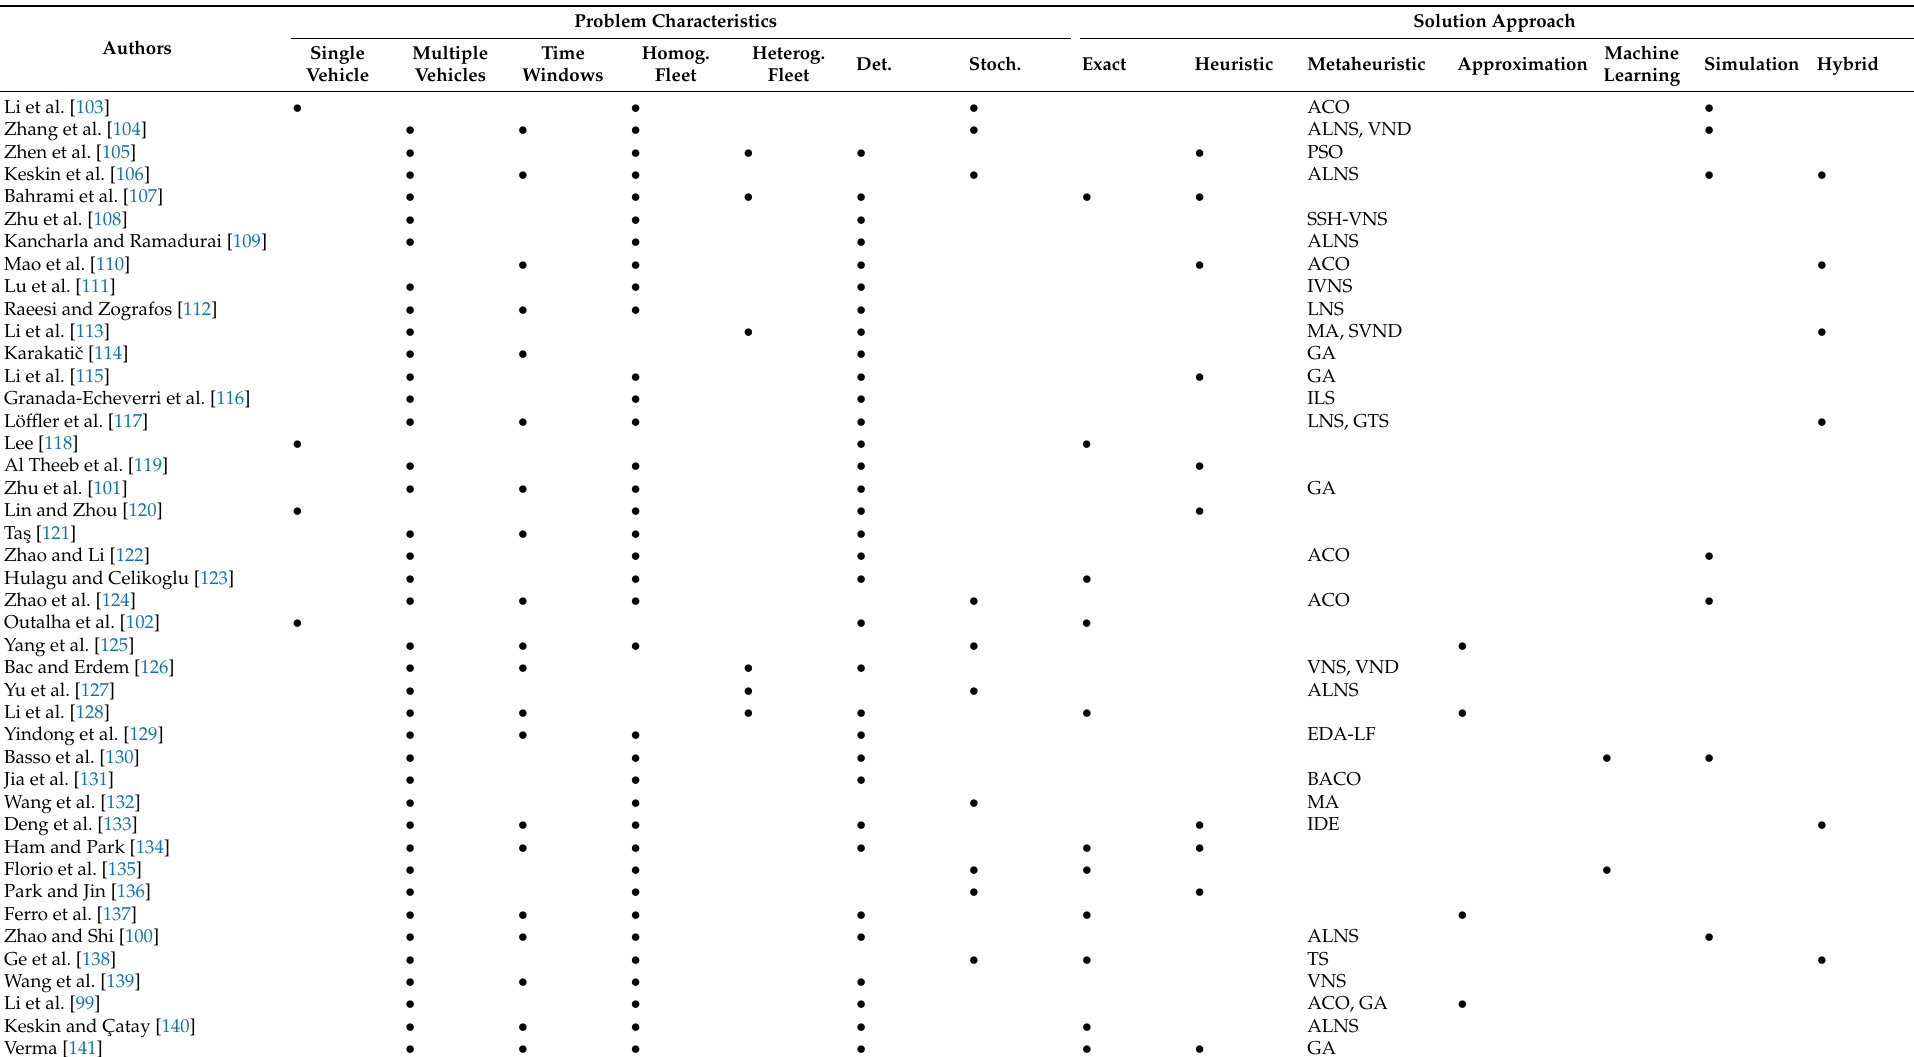
Table 1. Classification of recent papers on the E-VRP according to the problem characteristics and the solution